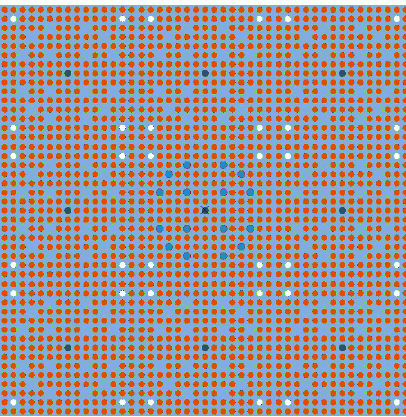
Figure 1: Radial view of the TMI-1 3x3 mini-core geometry implemented with ROOT for TRIPOLI-4. The central assembly contains 16 control rods (in blue). The burnable poison pins are represented in